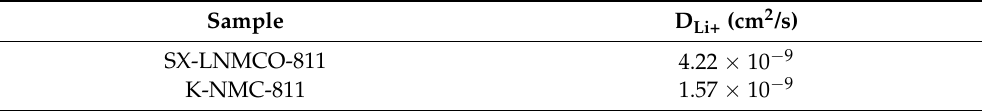
Table 10. Calculation of the lithium-ion diffusion coefficients in SX-LNMCO-811 and K-NMC-811